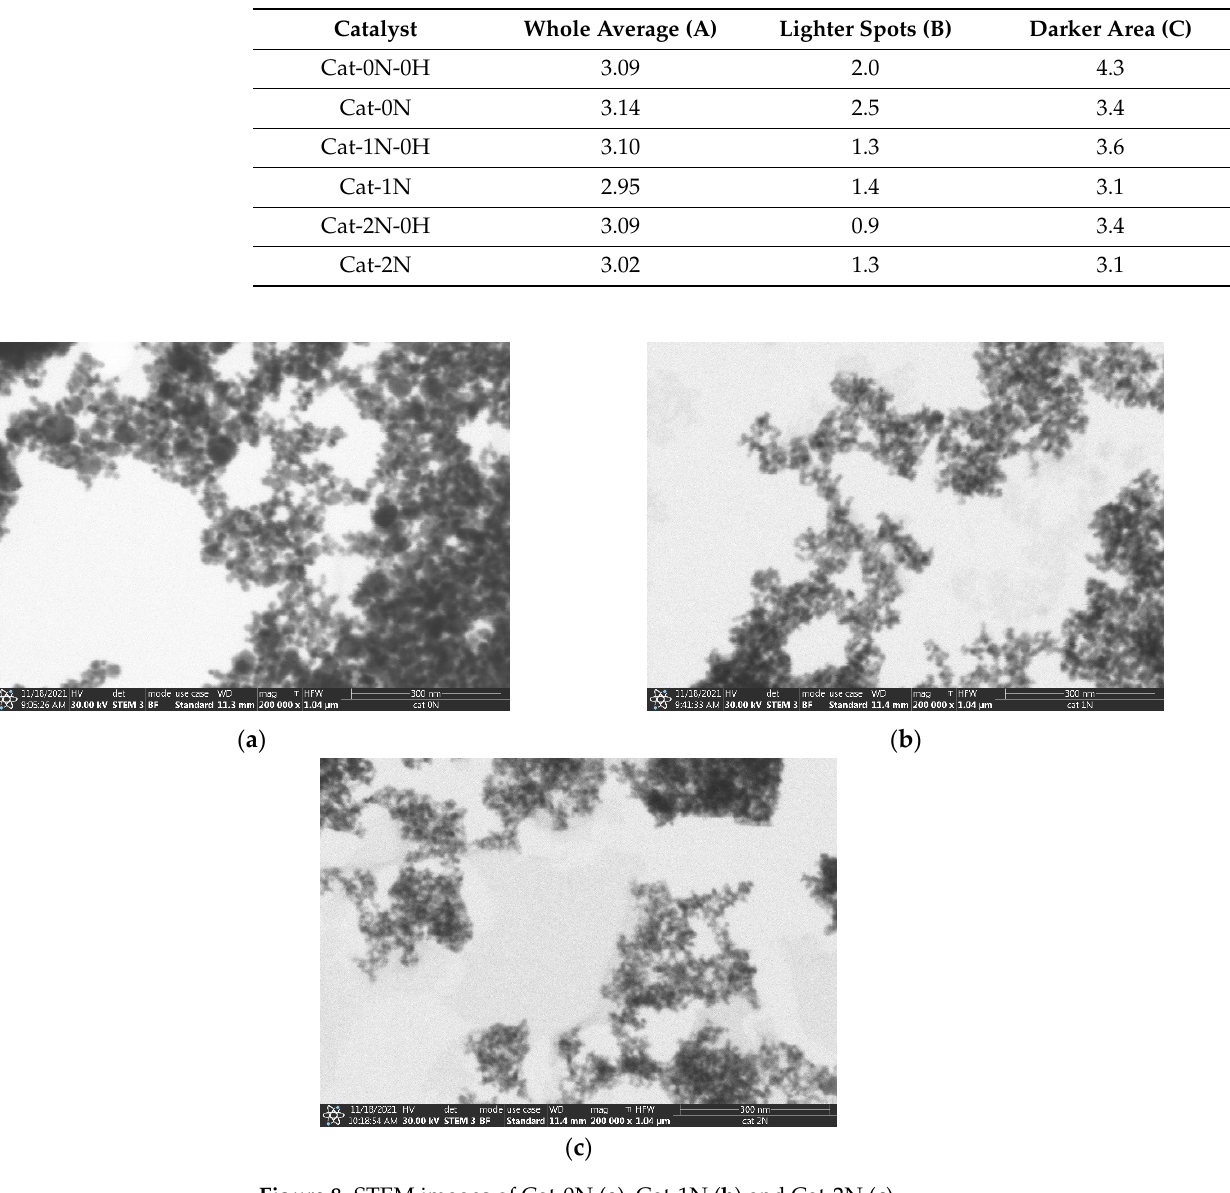
Figure 8. STEM images of Cat-0N ( a ), Cat-1N ( b ) and Cat-2N ( c